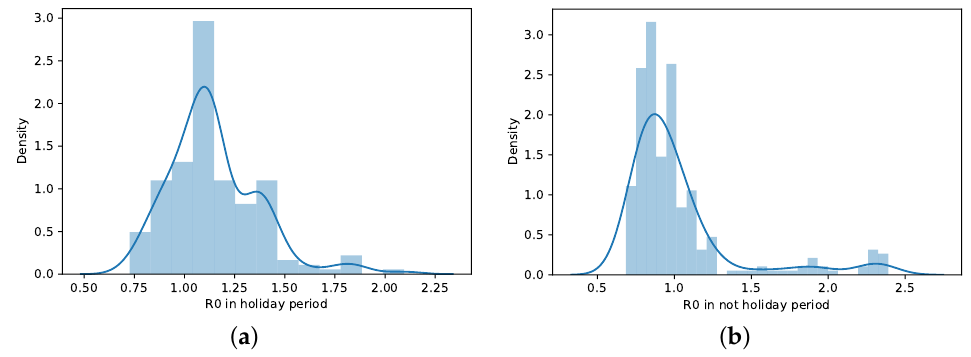
Figure 10. Histogram and distribution of R 0 in holiday and non-holiday periods. ( a ) R 0 distribution— holiday period. ( b ) R 0 distribution—non-holiday